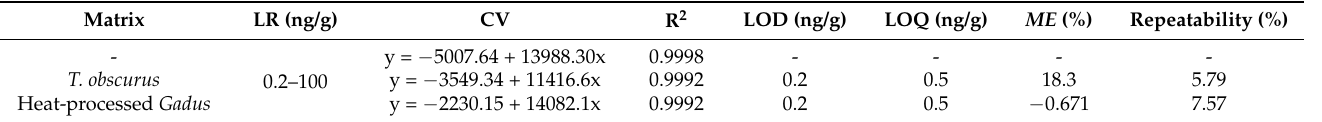
Table 2. Linear ranges, calibration curves, R 2 , LOD, LOQ, and ME of the developed method.